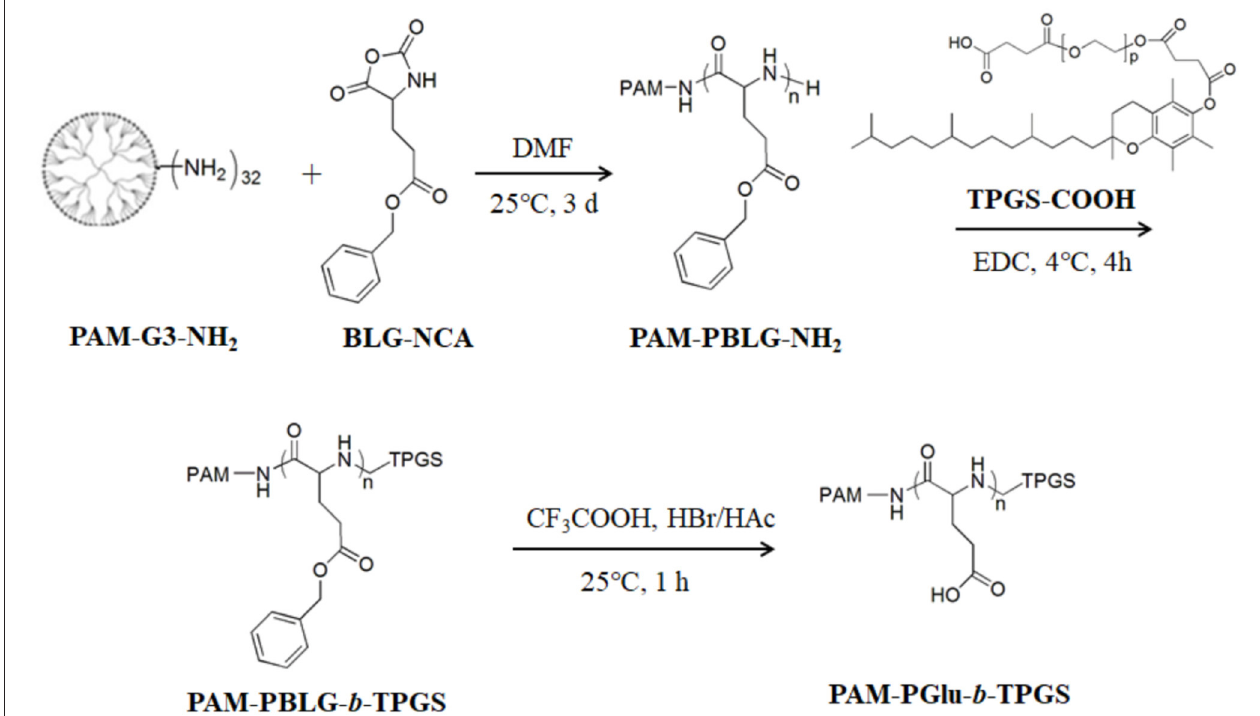
FIGURE 2 | Synthesis of the dendritic block copolymer PAM-PGlu- b -TPGS.